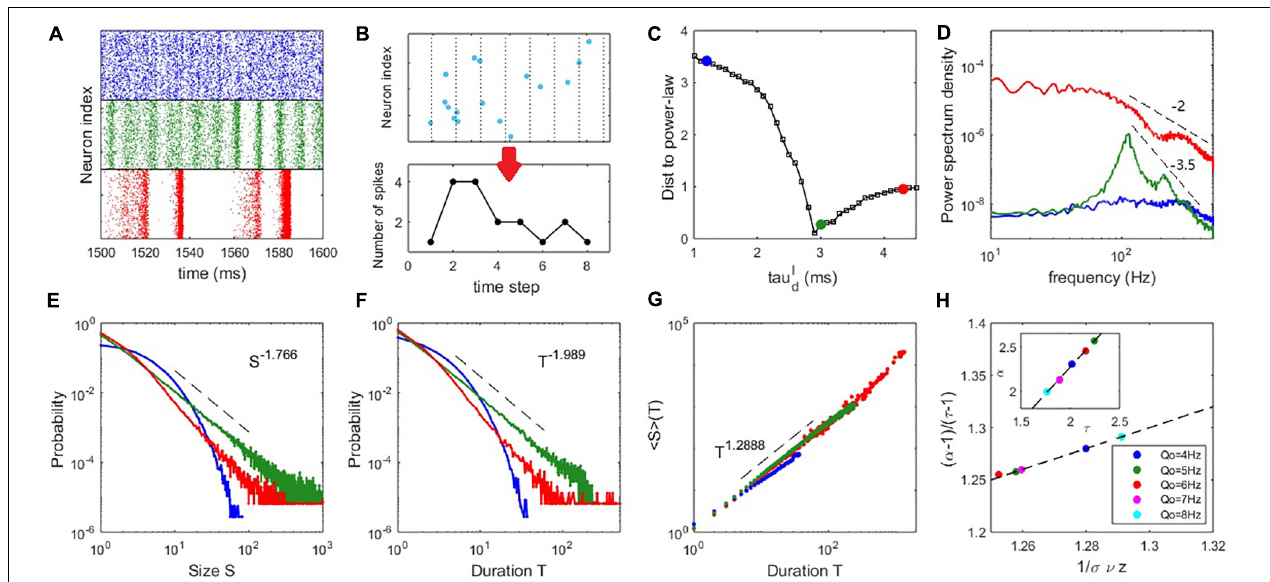
FIGURE 3 | Critical dynamics near the onset of collective oscillation. (A) The raster plots of the spiking time of the excitatory neurons at τ I d = 1 . 2 ms (upper panel), τ I = 4 . 3 ms (lower panel). (B) An example of the time course of an avalanche. (C) The distance between the avalanche size = 3 ms (middle panel), and τ I d d distribution and its best-fitting power-law distribution. (D) The PSD of the network excitatory firing rate. (E) The probability density distribution of the avalanche size. (F) The probability density distribution of the avalanche duration. (G) The mean avalanche size with respect to a given avalanche duration. For panels (D–G) , the blue, green and red curves correspond to the cases of τ I d = 1 . 2 , 3 , 4 . 3 ms , respectively. (H) Scaling relation Equation (16) approximately holds for critical states ( τ I d = 3 ms ) with different input strengths Q o , where the dashed line represents Equation (16) exactly holding. The inset shows an approximate linear relationship between exponents τ and α . Here, Q o = 5 Hz is used in panels (A–D) and the example of panels (E–G) is Q o = 8 Hz